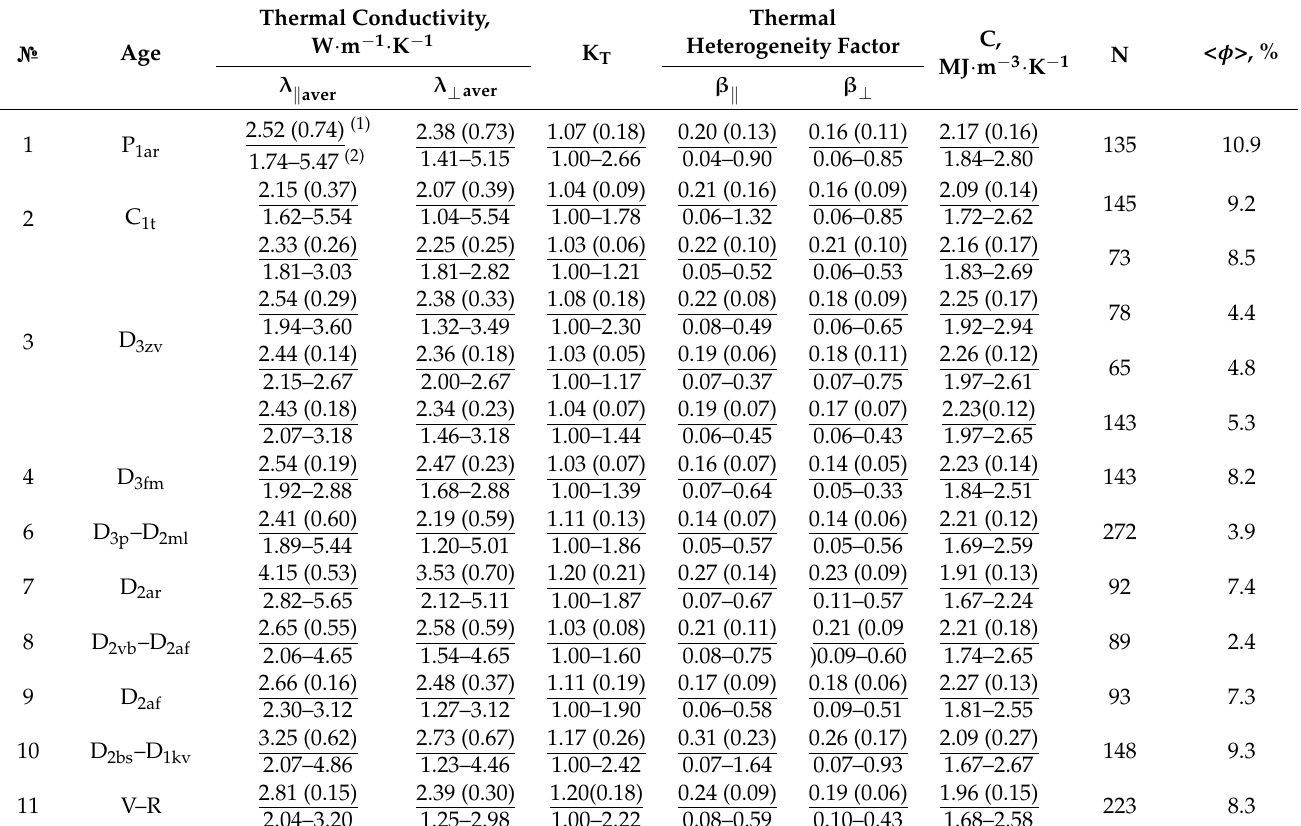
Table 3. Statistical characteristics of the deposits penetrated by the